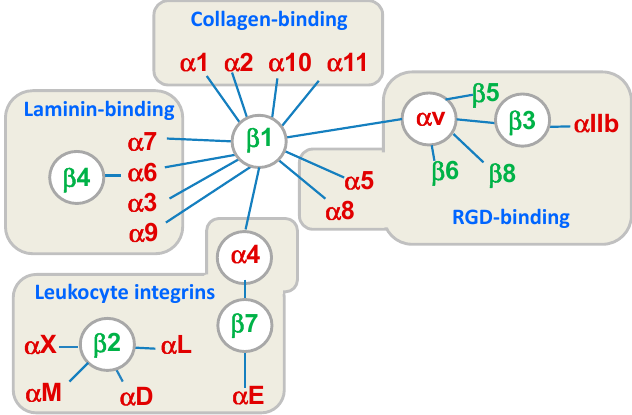
Figure 1. Classification of the 24 integrin heterodimers according to the combination of the subunits α and β , their specific ligands, or cell type. RGD: Arg-Gly-Asp.